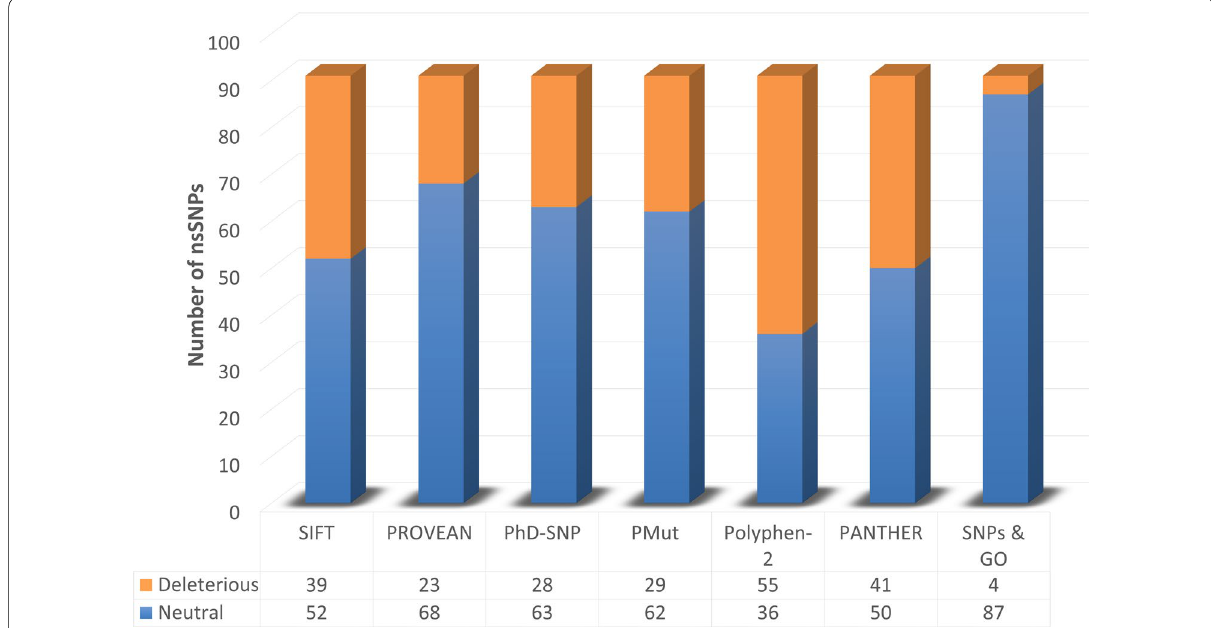
Fig. 2 The bar chart representing the distribution of deleterious (orange color) and neutral (blue color) nsSNPs predicted by the seven in silico tools—SIFT, PROVEAN, PhD-SNP, PMut, PolyPhen-2, PANTHER, and SNPs &